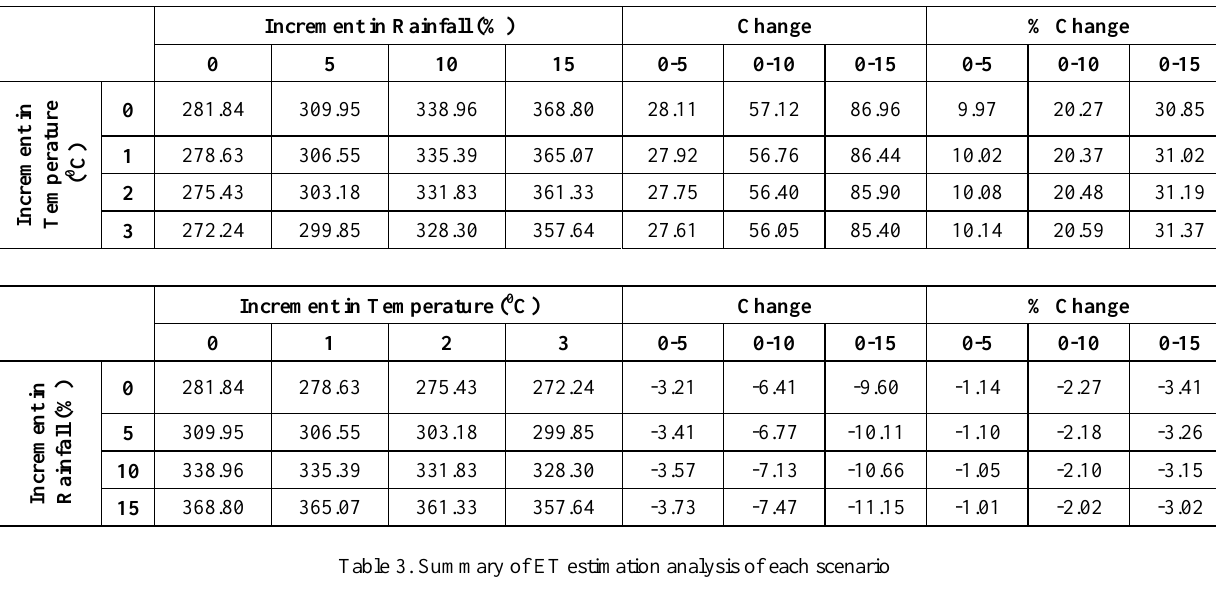
Table 2. Summary of runoff estimation analysis of each scenario